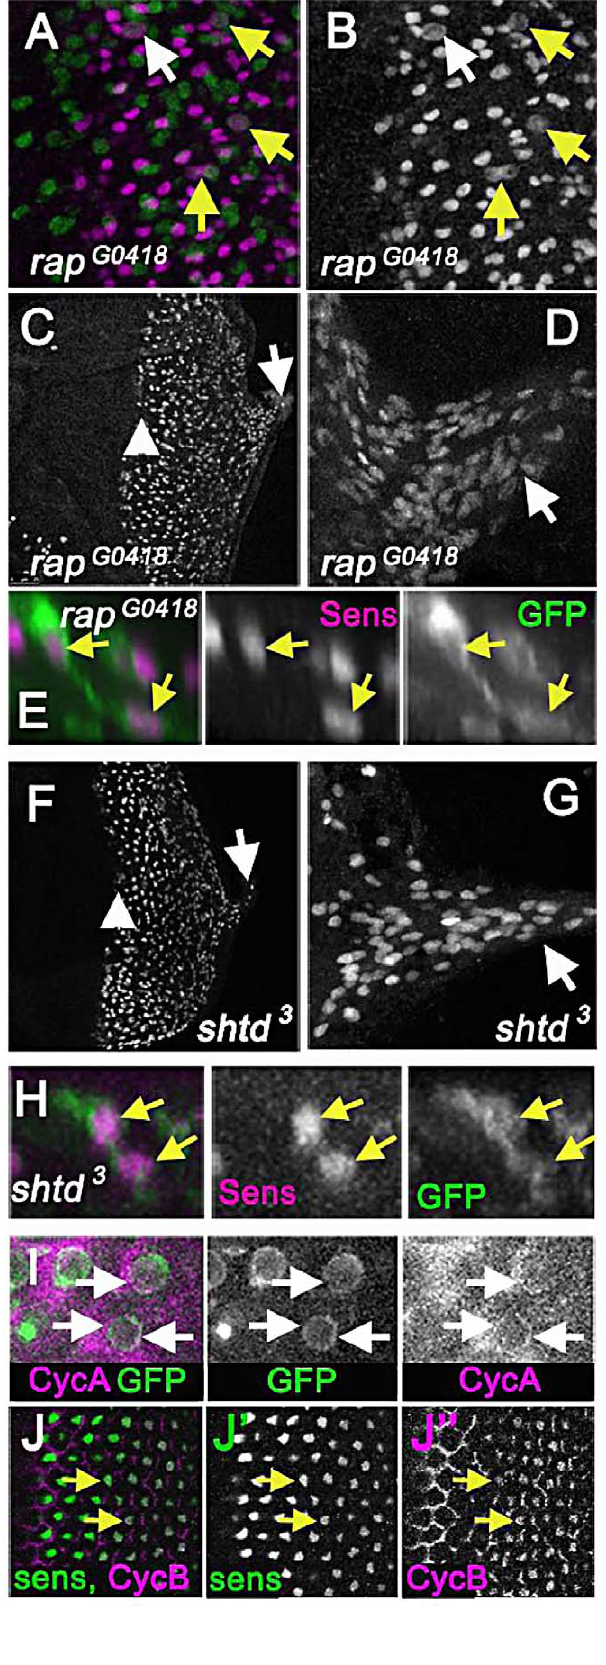
Figure 6. APC1 and Cdh1 maintain cell cycle exit. (A) Eye disc carrying the rap G0418 mutation in the cdh1 locus labelled for Senseless (magenta) and mitotic figures (anti-H3p in green) showing mitotic R8 cells (arrows). R8 neurons appeared to enter the cell cycle earlier than in rux , so that nearly 10% of intermediate groups contained a mitotic cell and 20% of R8 cells in column 0 labeled with H3p (white arrow). (B) Sens channel reveals mitotic R8 nuclei (arrows). (C) R8 cells become disorganized soon after the morphogenetic furrow (arrow head). R8 nuclei can be seen in the optic stalk (arrow). (D) R8 nuclei labeled with sens in the optic stalk of a rap G0418 eye disc. (E) A binucleated rap G0418 mutant R8 cell expressing GFP (green) and labeled for Sens (magenta). (F) Senseless staining of an eye discs carrying the shtd 3 mutation in the apc1 locus. R8 cells become disorganized soon after the morphogenetic furrow (arrow head). R8 nuclei can be seen in the optic stalk (arrow). (G) Enlargement of shtd 3 optic stalk. (H) A binucleated rap G0418 mutant R8 cell expressing GFP (green) and labeled for Sens (magenta). (I) Cytoplasmic Cyclin A (magenta) is observed around the R8 nuclei in columns 0 and 1 (arrows), in addition to the labeling of unspecified cells in the second mitotic wave observed previously [28]. R8 cells labeled by 109-68 . GFP (green). (J) Cyclin B staining (magenta) co-localizes with senseless (green) staining in wild type eye discs as beginning in column 4, and in all R8 cells by column 6 (arrows). Cyclin B appears nuclear in R8